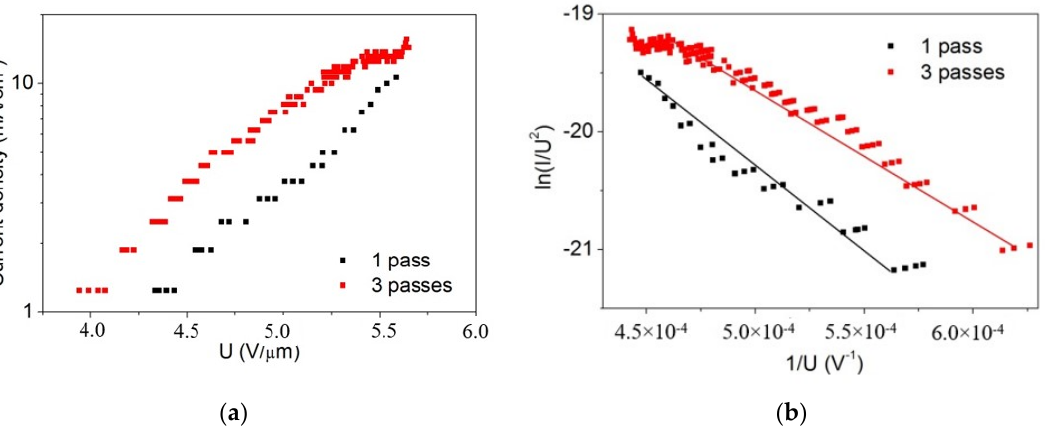
Figure 5. ( a ) Field emission current density versus the electric field and ( b ) FN plot for the printed graphene cathodes after single and triple laser exposure.